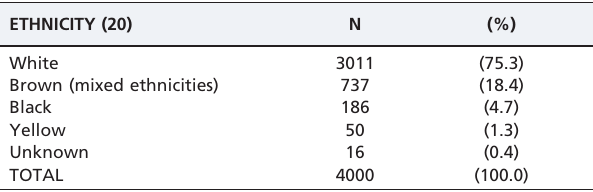
Table 1 - Ethnic distribution (20) of blood donors in Sa˜o Paulo city from September 2003 to August 2004.